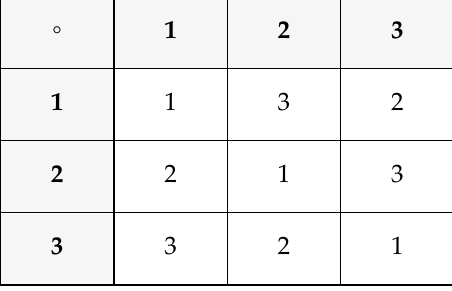
Table 2. Right almost-group.